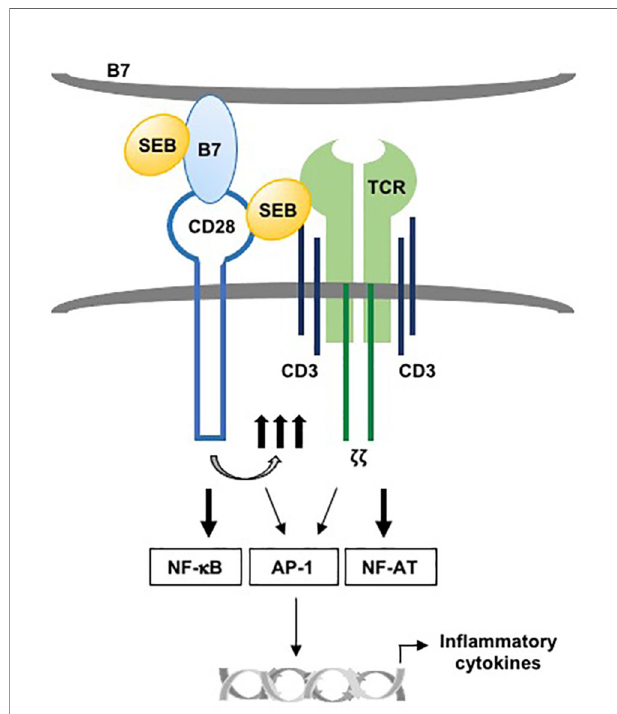
FIGURE 8 | Schematic model of activation of TCR and CD28 by SEB in presence of B7. The binding of SEB to B7 as well as to TCR and CD28 promotes the activation of TCR and CD28 signalling. NF-AT is primarily regulated by TCR signalling, while NF-kB activation is under the control of CD28. AP-1 activation requires both TCR- and CD28-mediated signalling. The collaboration between TCR- and CD28/B7-mediated signalling in response to SEB leads to the production of pro-in fl ammatory